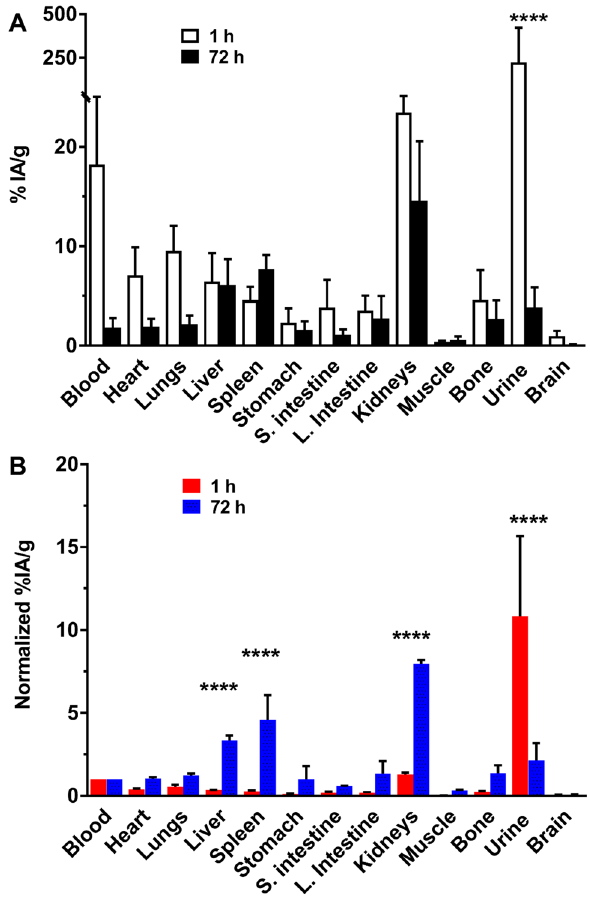
Figure 5. Biodistribution and clearance of [ 225 Ac]fCNC in immunocompetent mice at 1 and 72 h post intravenous administration showing tissue biodistribution, blood clearance and renal elimination. ( A ) The percent of the injected activity per gram (%IA/g) of [ 225 Ac]fCNC in each sample and ( B ) the %IA/g normalized to blood activity showing the specific accumulation of fCNC in liver, spleen, and kidney along with elimination into the